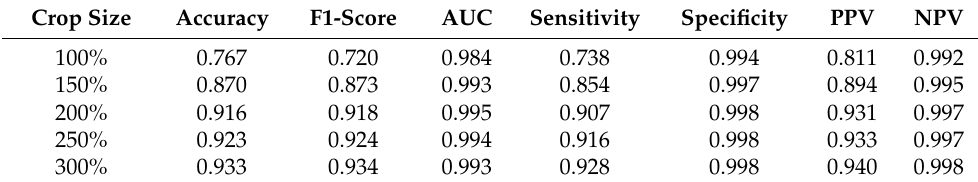
Table 3. Mean performance of the models on validation set. Crop Size